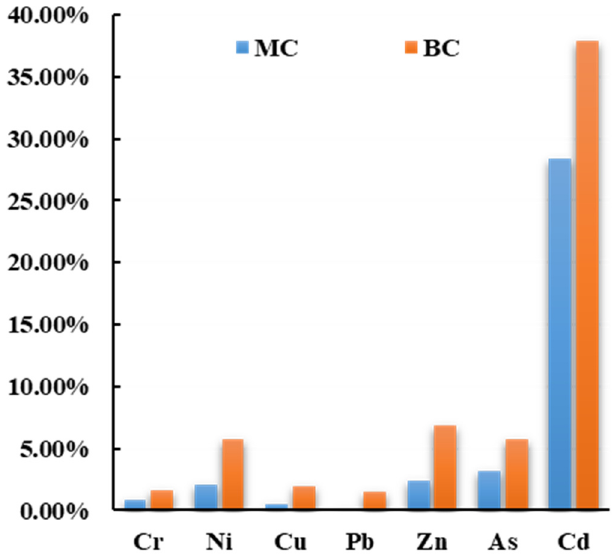
Figure 3. Column diagram of mobility coefficient and bioavailability coefficient of heavy metal.